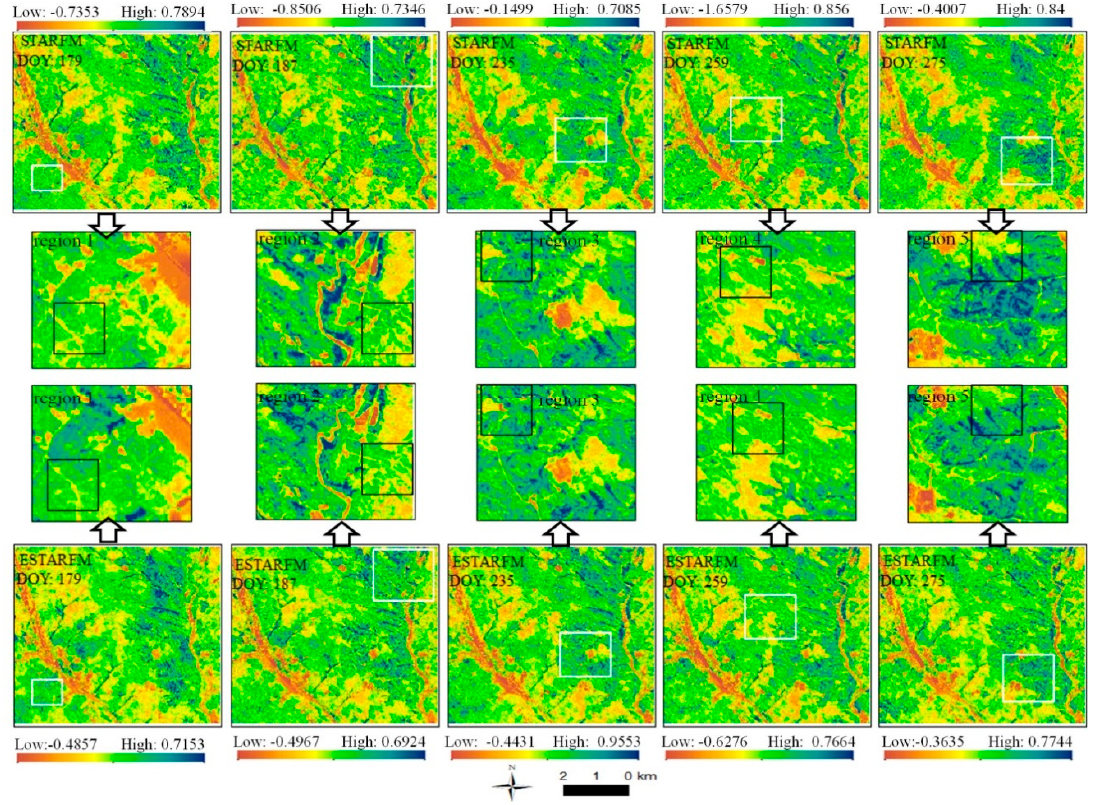
Figure 7. A comparison of the local enlarged region of the NDVI extracted from both STARFM and ESTARFM prediction images in the growing season.